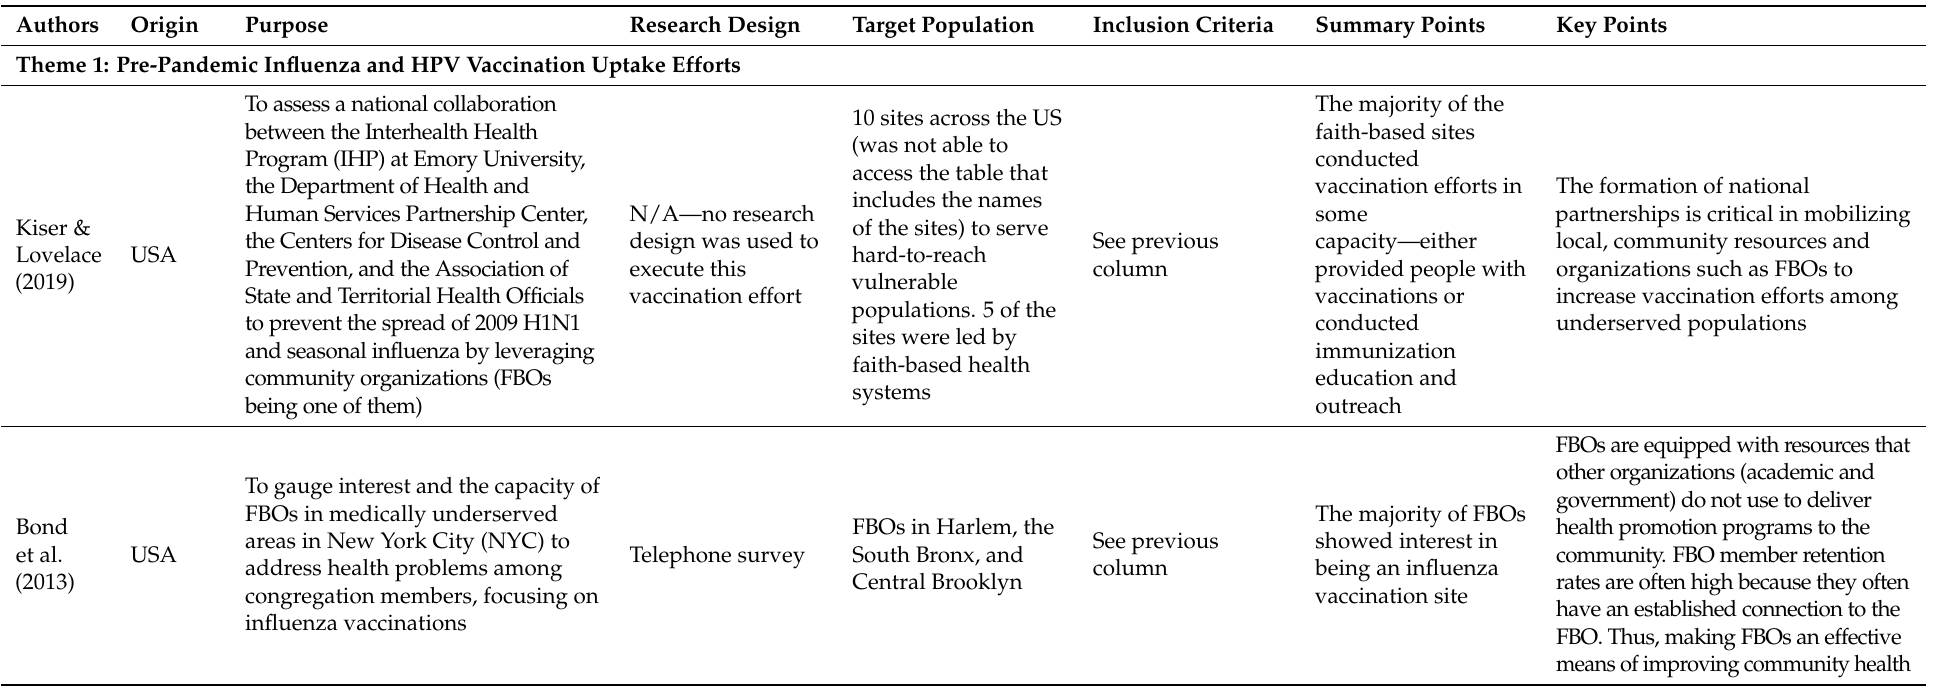
Table 2. Summary of Published Studies Focused on the Role of Faith Based Organizations (FBOs) in Vaccination